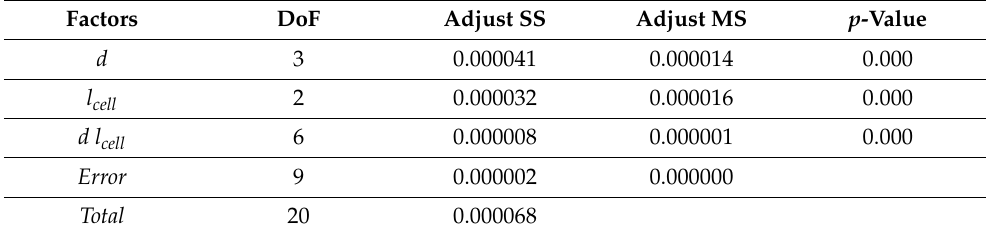
Table 4. Results of the ANOVA for the FP1 testing plan.